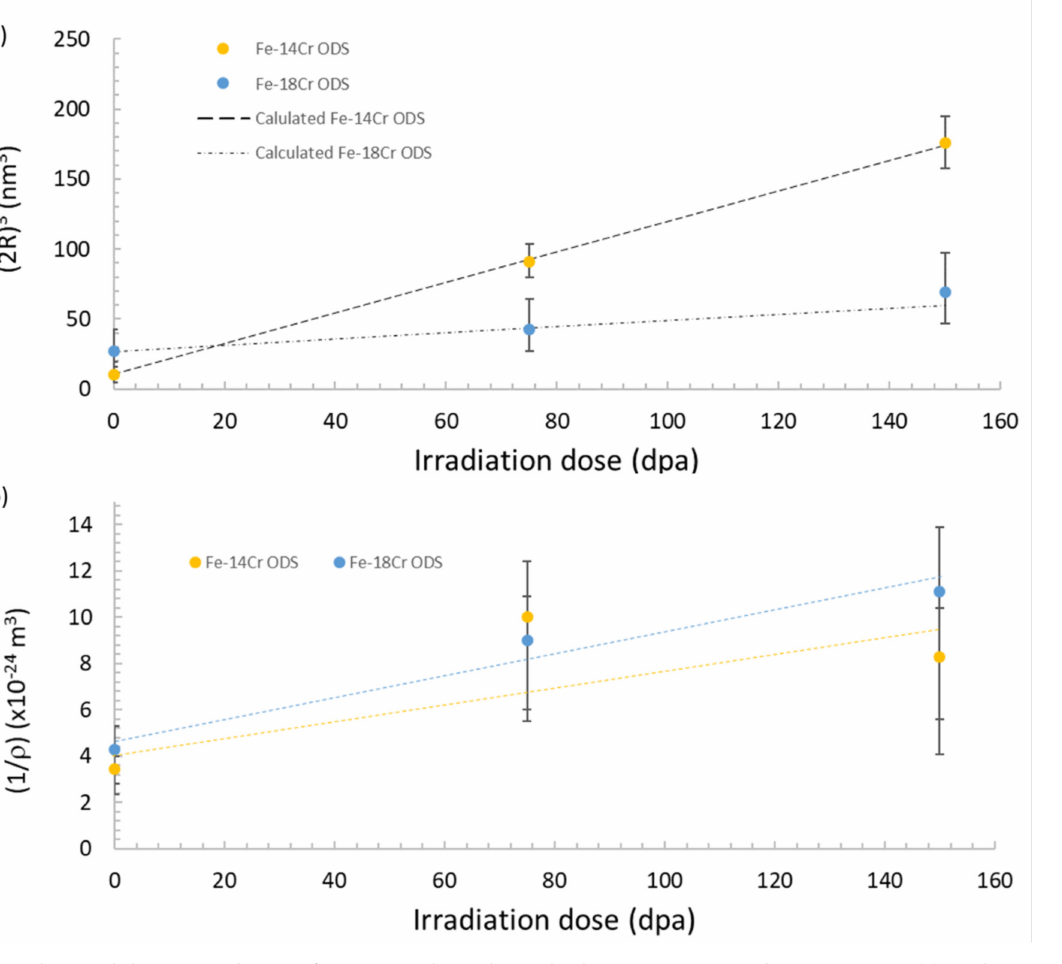
Figure 13. Radius and density evolution after 0, 75 and 150 dpa in both Fe-14Cr ODS and Fe-18Cr ODS: ( a ) evolution of the cube diameter against irradiation damage, ( b ) evolution of the inverse of the density against irradiation